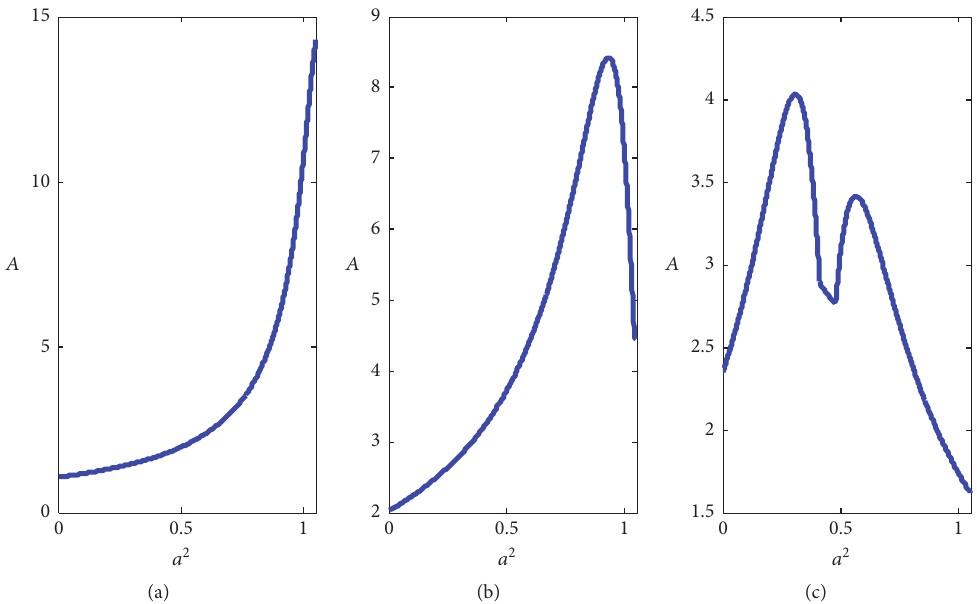
Figure 5: The output amplitude 𝐴 versus the noise intensity 𝑎 2 with various (𝐷,Ω) chosen through Figure 4, with parameters 𝜔 2 0 = 1 , 𝐴 1 = 1 , = 1 , 𝛾 = 0.3 , and V = 0.05 and (a) 𝐷 = 0.1 and Ω = 0.05 ; (b) 𝐷 = 1.1 and Ω = 0.25 ; (c) 𝐷 = 0.4 and Ω = 0.7 𝛼 = 0.6 , 𝜏 = 0.2 , 𝐴 2